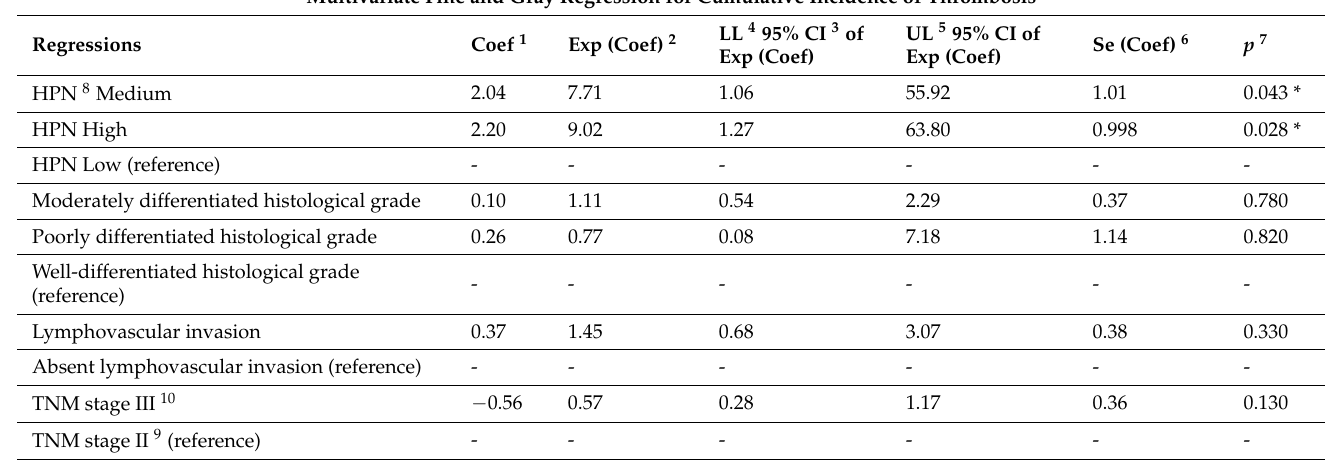
Table 4. Multivariate Fine and Gray regression model for the cumulative incidence of thrombosis in localized patients at diagnosis.